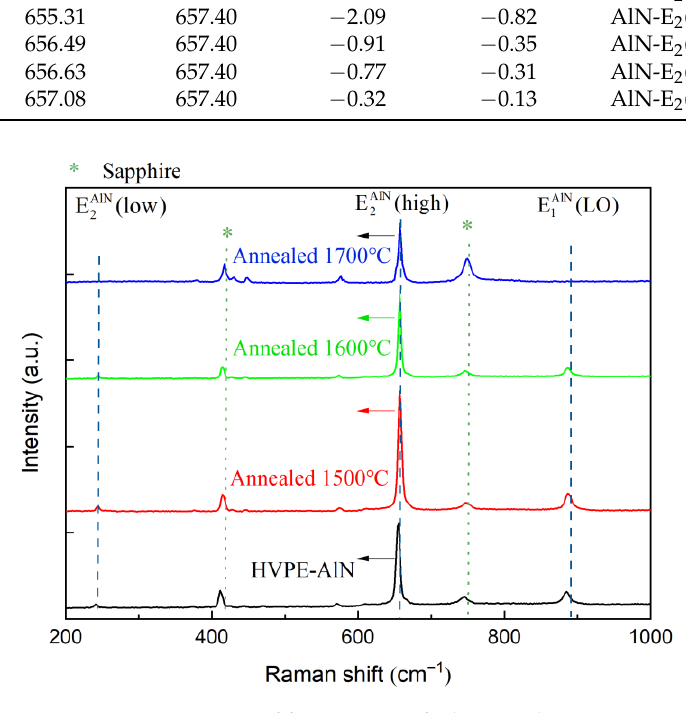
Figure 3. Raman spectra of four groups of AlN samples. Table 1. Stress modes in four groups of AlN samples.